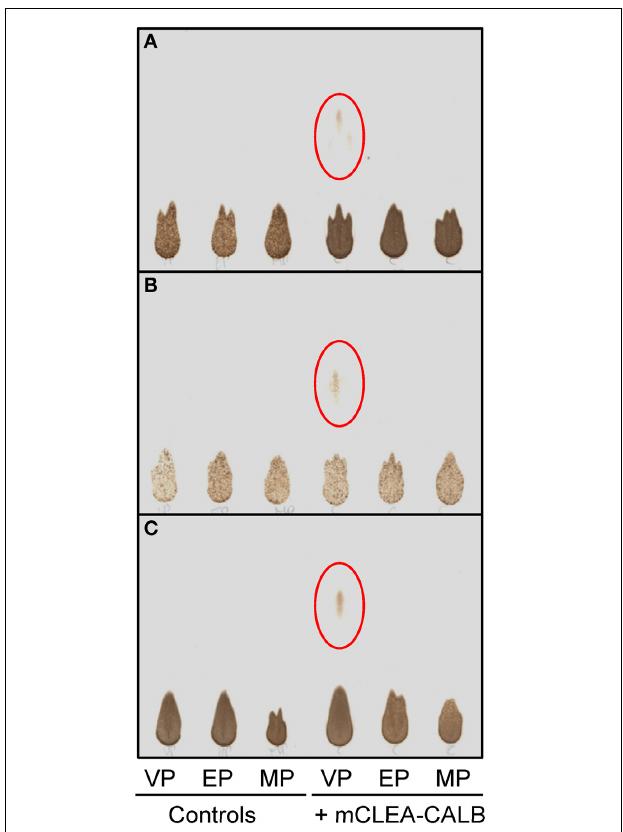
FIGURE 10 | Analysis by TLC of the SMP conversion from sucrose and different alkyl palmitates catalyzed mCLEA-CALB. The reaction mixture containing 100mg/ml sucrose (292mM), alkyl palmitate and 4mg/ml mCLEA-CALB in 1ml DMSO was incubated for 24h at 60 ◦ C. Vinyl palmitate (VP), methyl palmitate (MP), and ethyl palmitate (EP) were used. Sucrose:alkyl palmitate molar rates were 1:1 in (A) , 1:2 in (B) , and 1:3 in (C) .